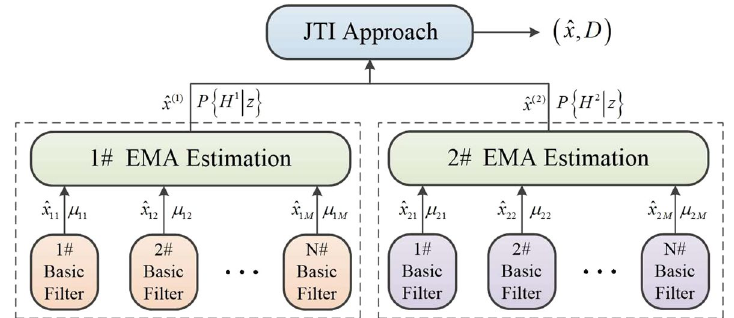
Fig. 2 Estimation strategy of JTI in complex traffic